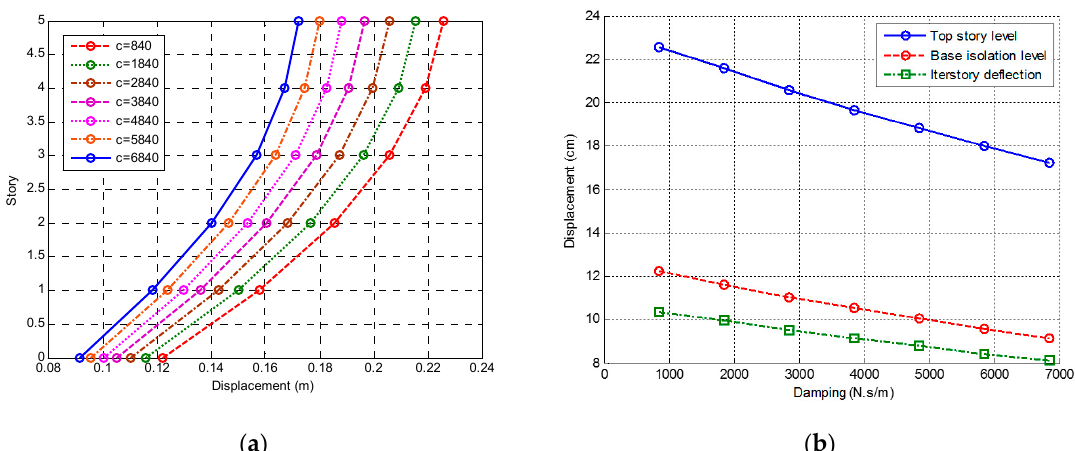
Figure 14. The results of ( a ) peak displacement for different damping of isolated support and ( b ) peak displacement at the base isolation level and top story level for different damping of isolated support under the El Centro earthquake.